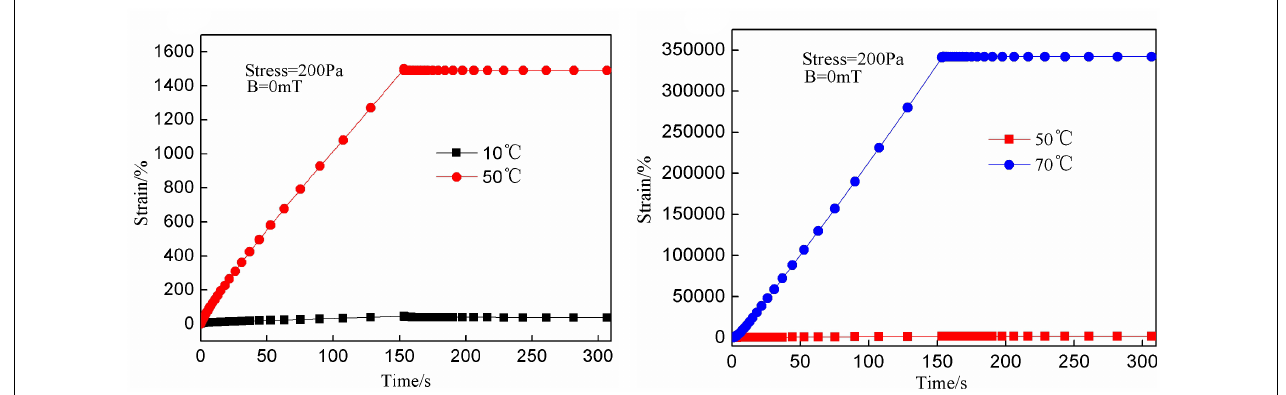
FIGURE 9 | The creep and recovery curves of MRG-70 under a 200 Pa constant stress for MRG-70 at different temperatures.